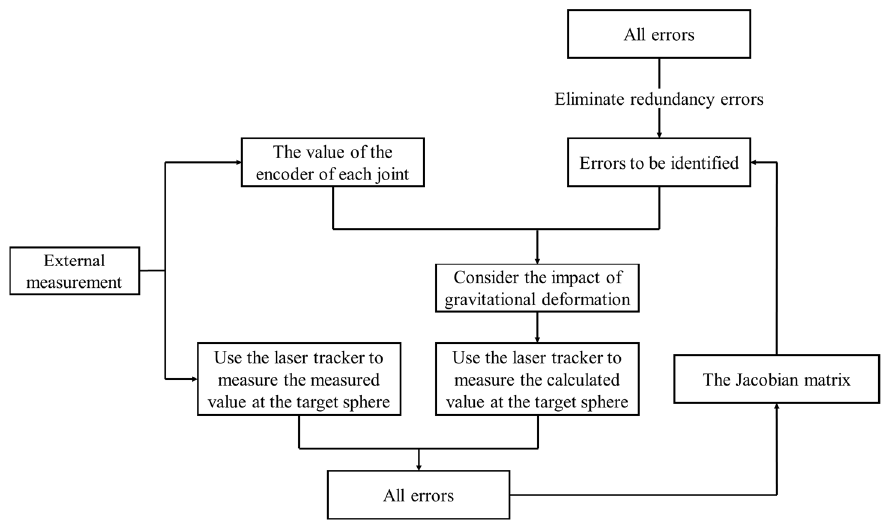
Figure 8. Calibration